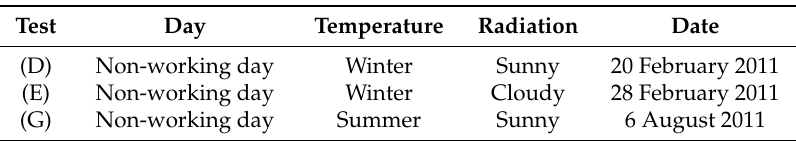
Table 19. Results obtained by neural network and NAB models over Test D, for a PH of 1 h. Parameters